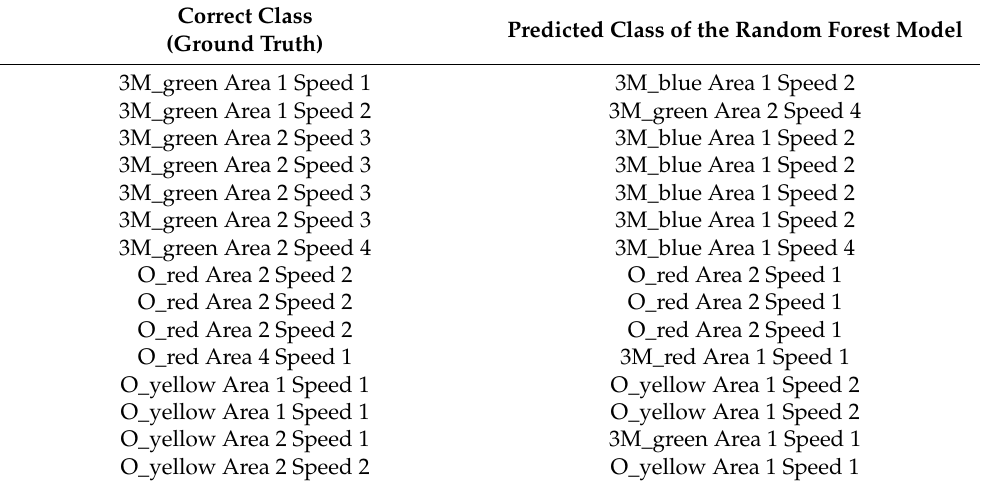
Table 10. Summary of the